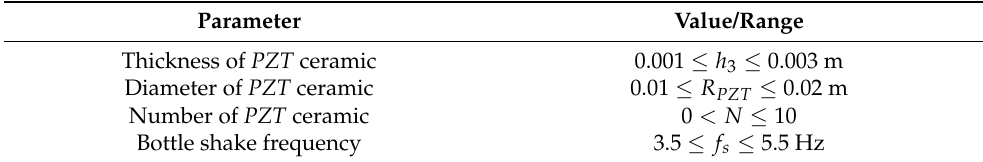
Table 2. Piezoelectric Energy Harvester Parameters.